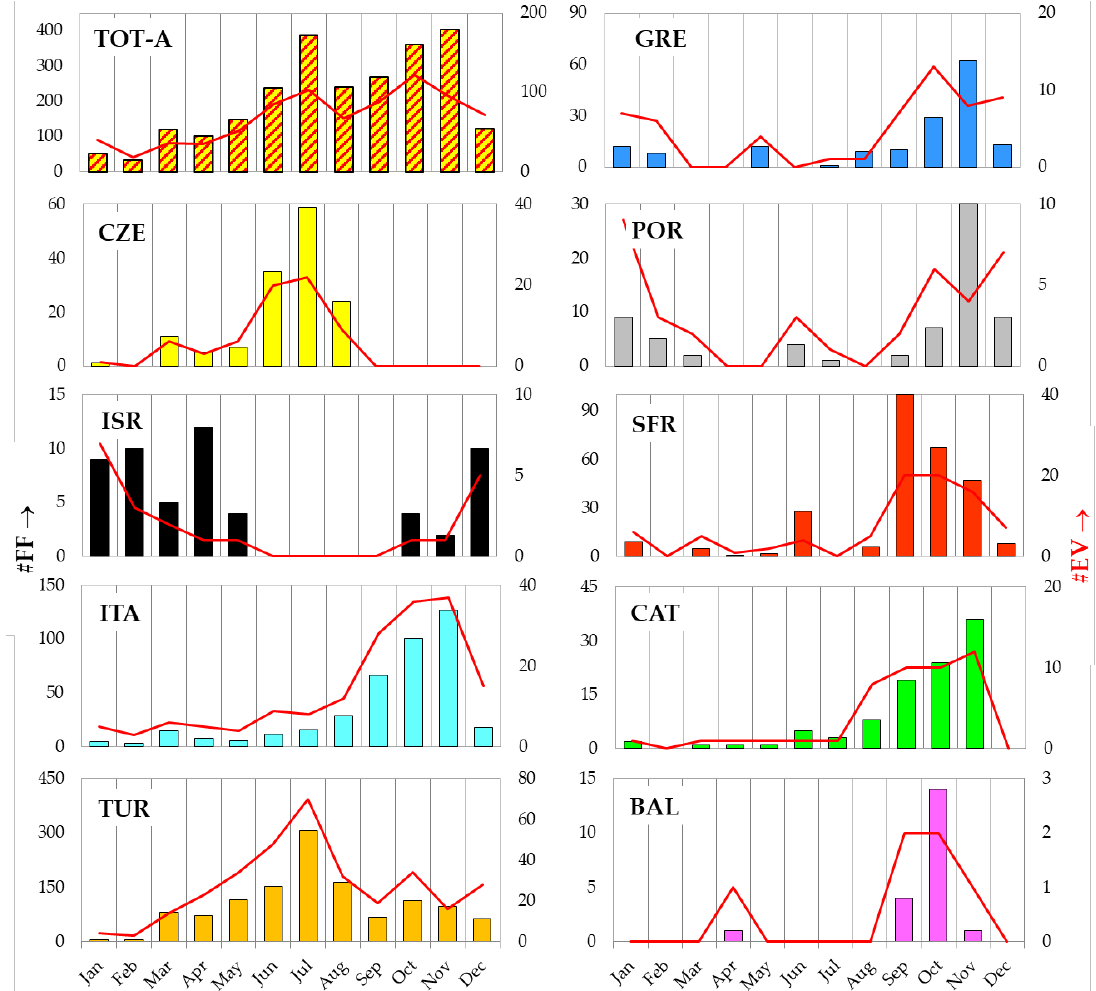
Figure 4. Monthly variation of flood fatalities (#FF, bars) and flood events (#EV) per each study area (SA).